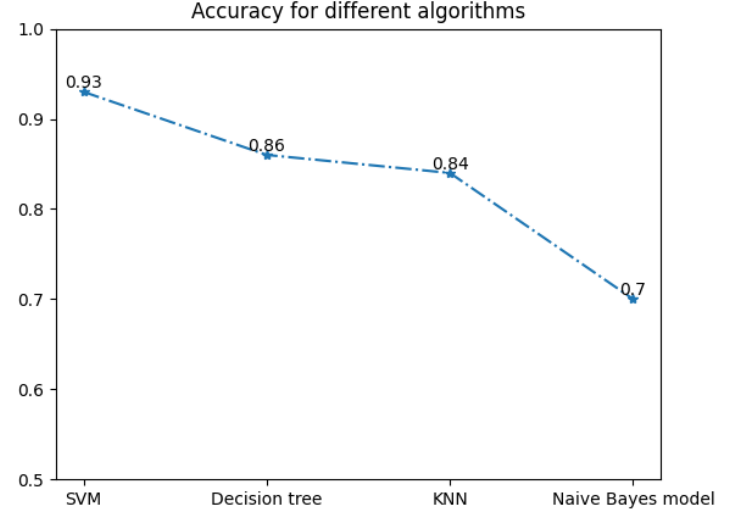
Figure 14. Accuracy for different algorithms.